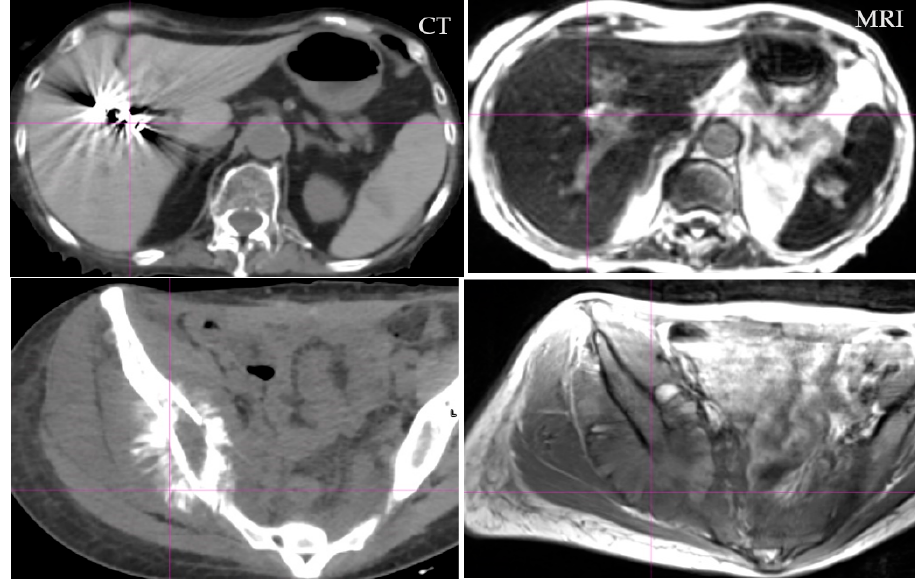
Figure 2. Two patients’ CT and MRI axial images. Note the significant artifact in CT image, which is nearly nonvisible in both 0.35 T (right top) and 1.5 T (left bottom) MRI image. Artifact is dependent on the density and atomic number (Z) of the